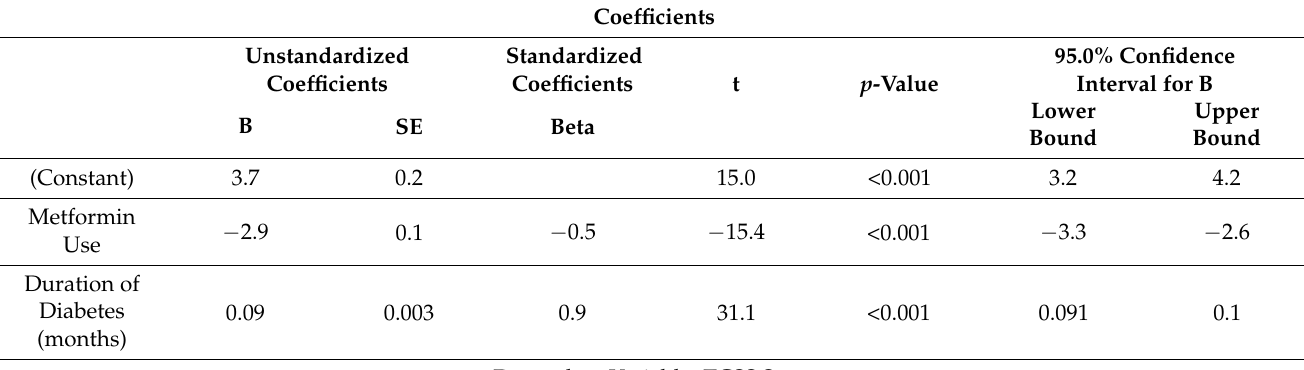
Table 7. Linear regression analysis, using TCSS score as a dependent factor and metformin use (yes/no) and duration of t2dm as independent factors.